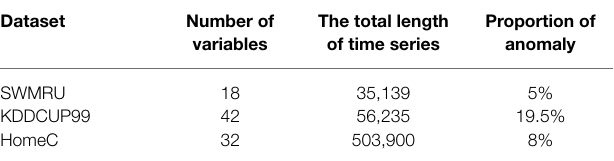
TABLE 1 | Details of